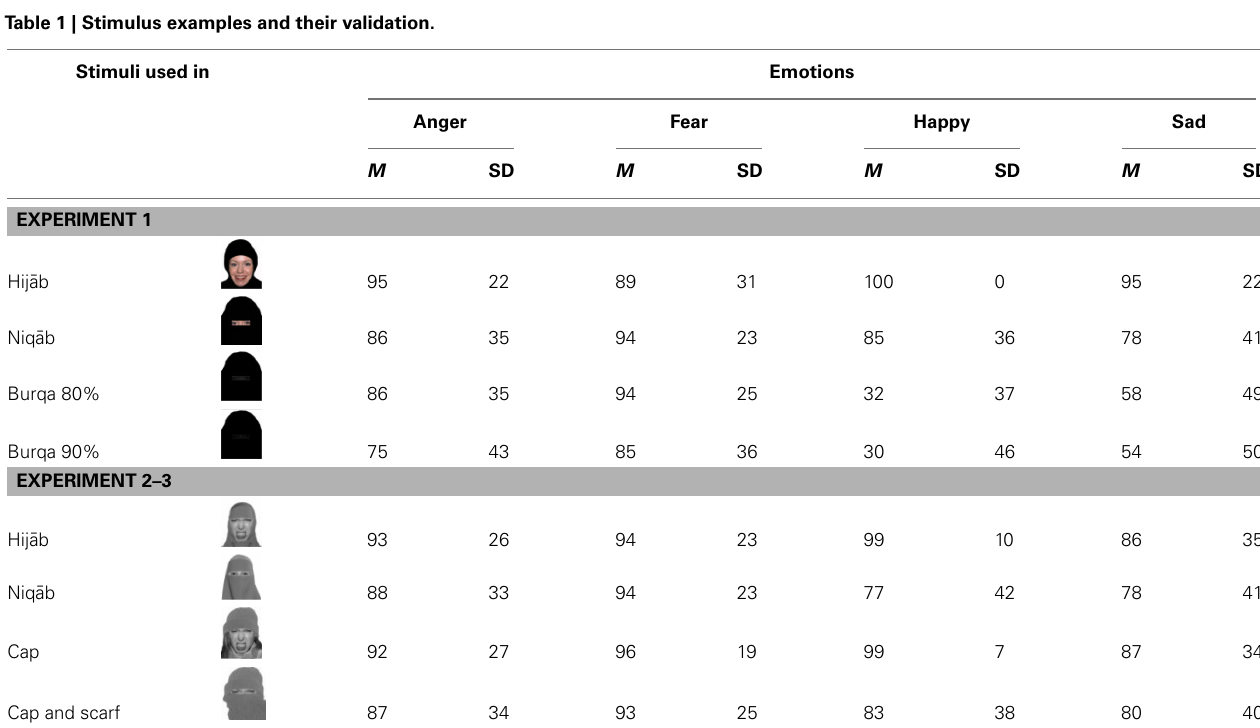
(2) in the context of a niq ¯ ab (a headscarf which only leaves the eyes visible), (3) in the context of a burqa where 80% of this region consisted of random noise, and (4) a burqa with 90% random noise.